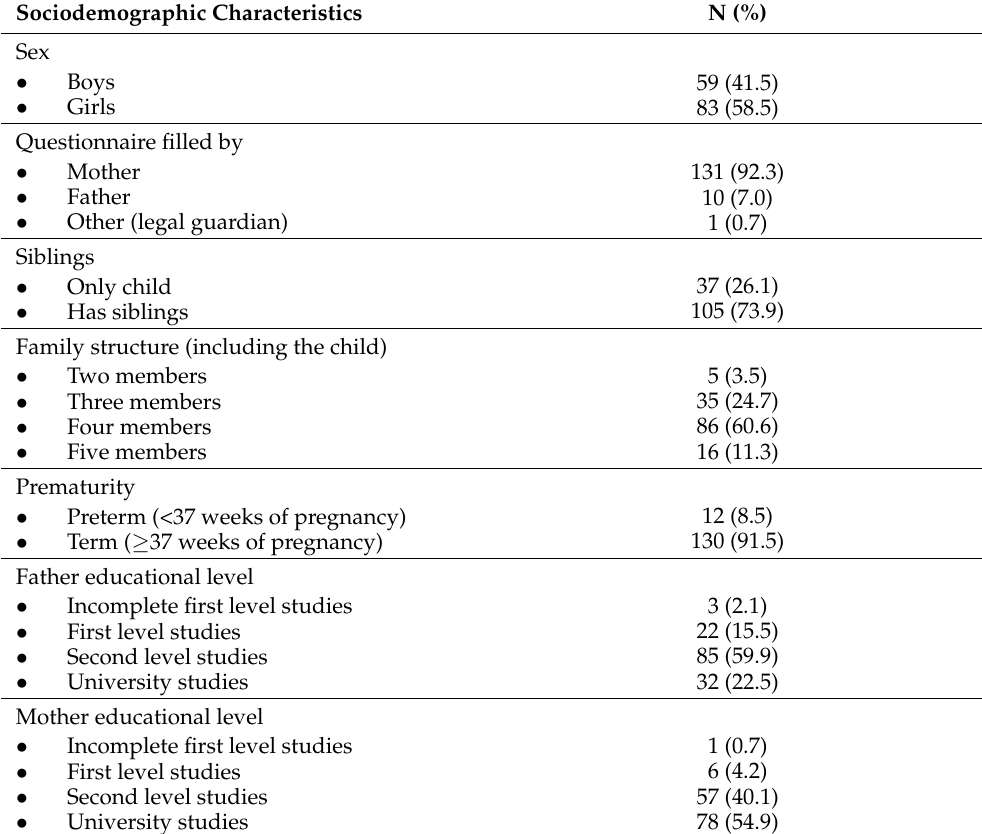
Table 1. Sociodemographic data of the participants ( n =